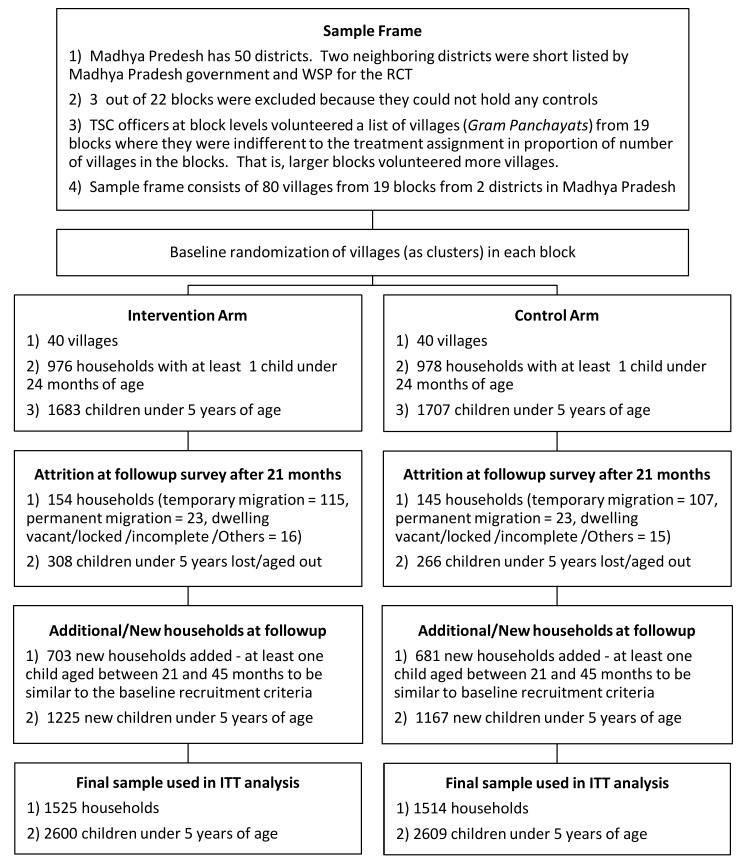
CONSORT Flowchart: enrollment, intervention allocation, attrition, and addition of participants.